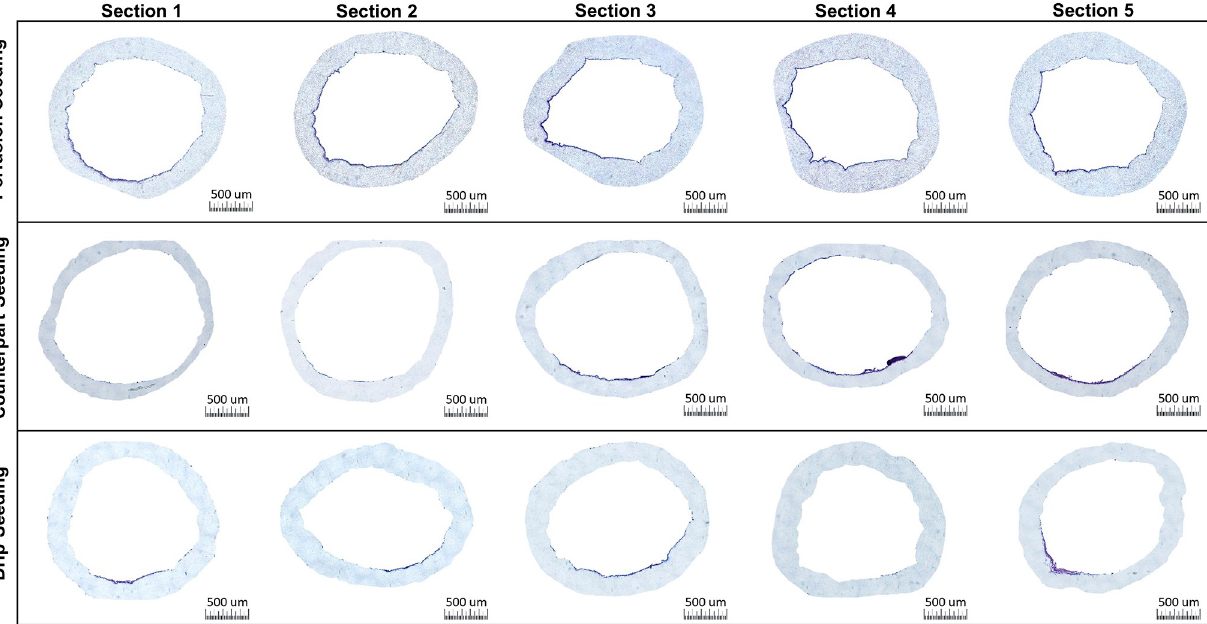
PLOS ONE | https://doi.org/10.1371/journal.pone.0269499 June 16,